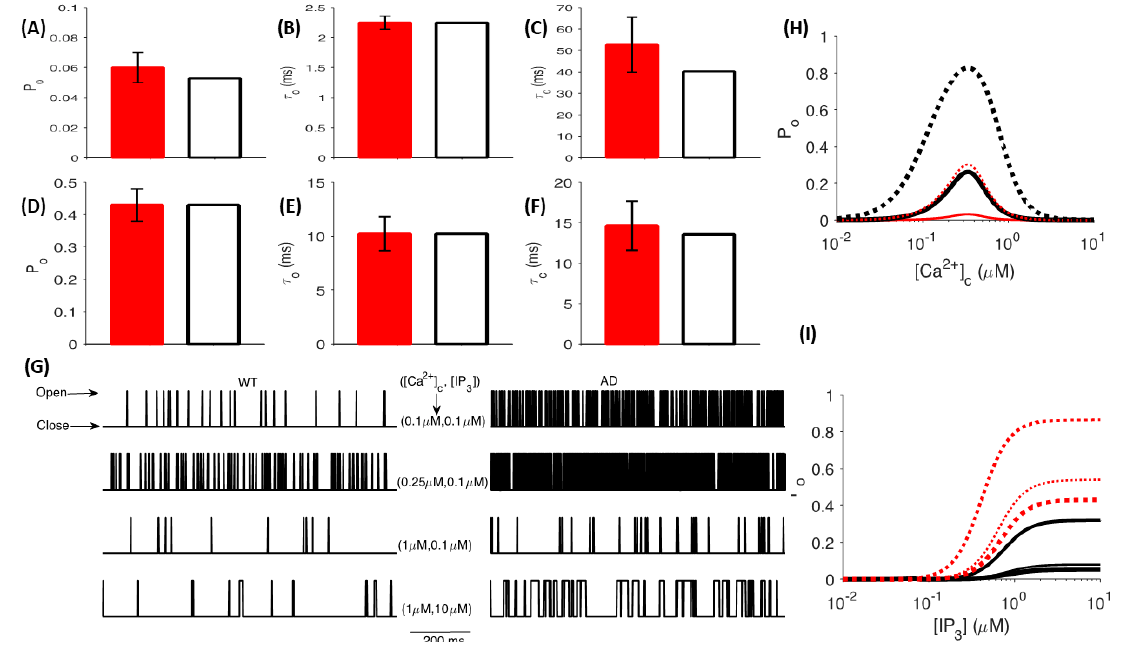
Figure 3. Gain − of − function enhancement of IP 3 R gating in FAD: The P o ( A , D ), τ o ( B , E ), and τ c ( C , F ) of IP 3 R given by the model (empty bars) and observed values in primary cortical neurons from WT ( A – C ) and 3xTg AD mice (filled bars) ( D – F ) at [ 𝐶𝑎 (cid:3030)(cid:3052)(cid:3047)(cid:2870)(cid:2878) ] = 1 μ M and [ 𝐼𝑃 3 ] = 10 μ M; ( G ) Sample time − traces generated by stochastically simulating a single IP 3 R channel in cortical neurons from WT (left column) and AD (right column) mice at different [ 𝐶𝑎 (cid:3030)(cid:3052)(cid:3047)(cid:2870)(cid:2878) ] and [ 𝐼𝑃 3 ] values shown in the figure; ( H ) P o of IP 3 R as a function of [ 𝐶𝑎 (cid:3030)(cid:3052)(cid:3047)(cid:2870)(cid:2878) ] at [ 𝐼𝑃 3 ] = 0.3 μ M (thin lines) and 1 μ M (thick lines) in WT (solid lines) and AD-affected (dotted) neurons; ( I ) P o of IP 3 R as a function of [ 𝐼𝑃 3 ] at [ 𝐶𝑎 (cid:3030)(cid:3052)(cid:3047)(cid:2870)(cid:2878) ] = 0.1, 0.25, and 1 μ M (the increasing value of [ 𝐶𝑎 (cid:3030)(cid:3052)(cid:3047)(cid:2870)(cid:2878) ] is represented by the thickness of the line) in WT (solid lines) and AD-affected (dotted) neurons. Experimental values shown for comparison in ( A − F ) are from [21].